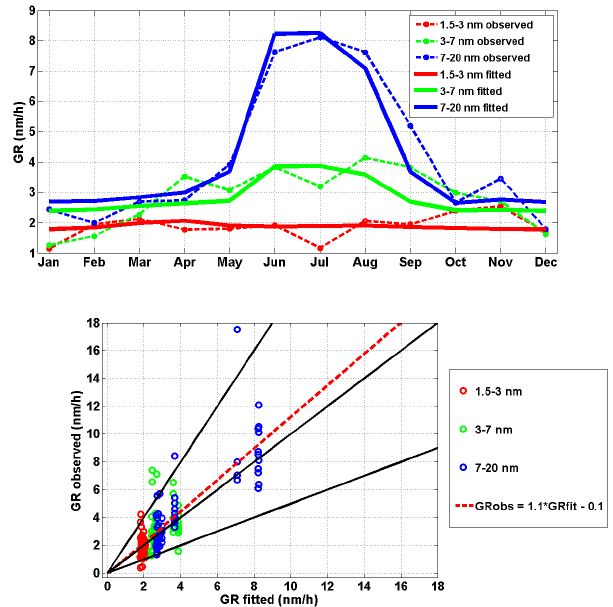
Fig. 3. Observed monthly median growth rates for three size ranges during 2003–2009 in Hyyti¨al¨a (symbols and dashed lines) and the growth rates from the mass flux fit (solid lines) using concentrations of SORG MT calculated using MT concentrations from GLOMAP (upper panel). See Table 3 for the fitting parameters. The corre- spondence between growth rates from the mass flux fit and from the ambient observations (monthly median growth rates for each year) is presented in the lower panel with a linear curve fitted to all the data points. Also, 1 : 1, 2 : 1 and 1 : 2 lines (black lines) are